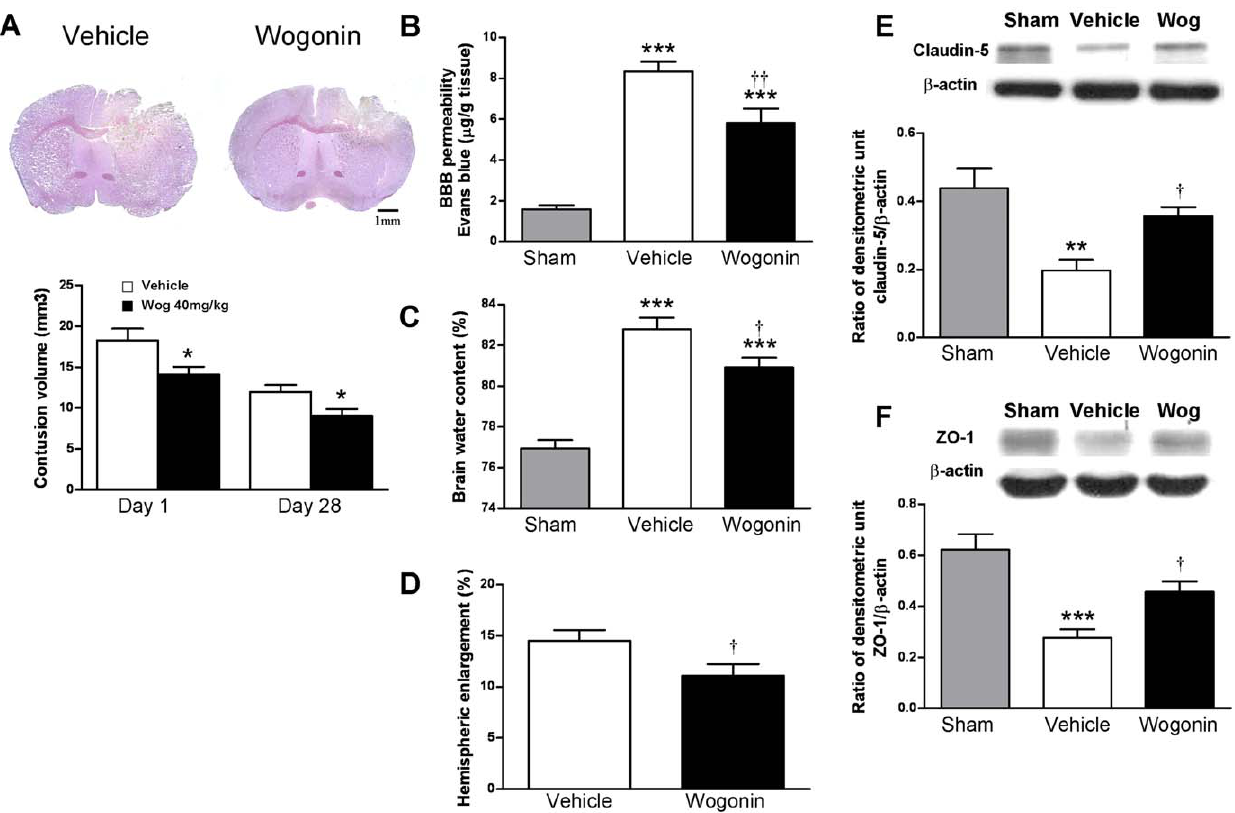
Figure 2. Effects of 40 mg ? kg 2 1 wogonin treatment on cortical contusion volume, brain edema, and BBB permeability. ( A ) Representative cresyl violet-stained brain sections of vehicle- and 40 mg ? kg 2 1 wogonin-treated mice 1 day post-TBI showing hypointense regions immediately below the impact site in the cortex. Scale bar is 1 mm. Quantification showed significantly smaller contusion volumes in wogonin- treated mice compared with vehicle-treated mice at days 1 and 28 post-TBI. ( B ) Wogonin-treated mice showed a significant decrease in the concentration of Evans blue (EB) in the ipsilateral hemisphere compared with vehicle-treated mice at day 1. ( C ) Brain water content in the ipsilateral hemisphere of 40 mg ? kg 2 1 wogonin-treated mice was significantly lower than in vehicle-treated mice at day 1. ( D ) At day 1, hemispheric enlargement was significantly smaller in mice treated with 40 mg ? kg 2 1 wogonin than in vehicle-treated mice. ( E, F ) Treatment with 40 mg ? kg 2 1 wogonin also reversed TBI-mediated reduced expression of claudin-5 and zonula occludens 1 in traumatic cortical areas of the ipsilateral hemisphere at day 1 following TBI, as measured by western blot. Values are presented as mean 6 SEM; ** P , 0.01, *** P , 0.001 versus vehicle-treated injured mice. { P , 0.05, {{ P , 0.01 for the 40 mg ? kg 2 1 wogonin-treated mice versus vehicle-treated mice. (n=8 mice/group for cresyl violet staining and hemispheric enlargement, n=7 mice/group for brain EB, brain water content, and western blot).